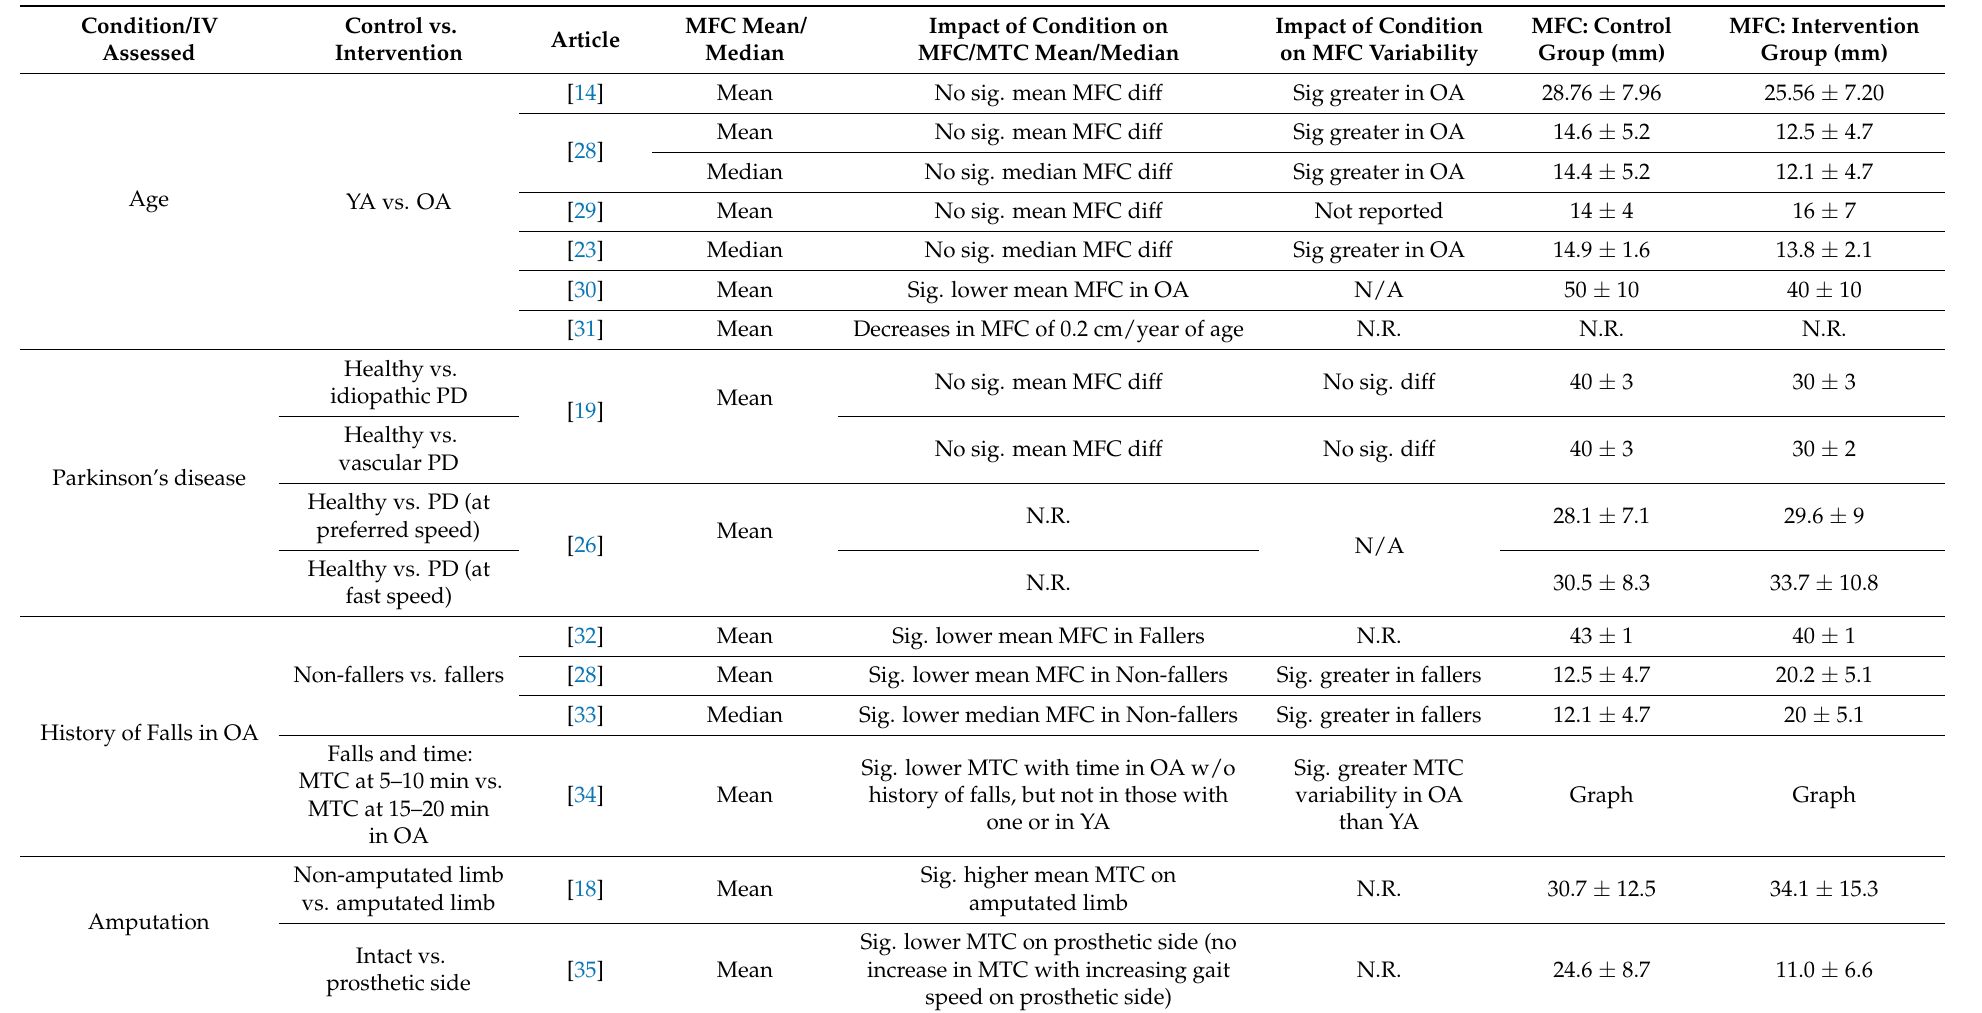
Table 2. Summary of findings in included papers for conditions without an impact on MFC mean or median relative to